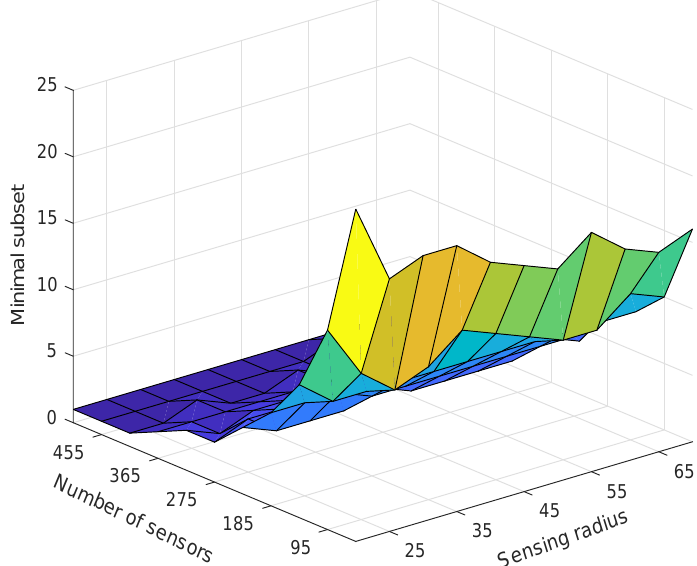
Figure 7. The change trend of the number of nodes in the minimum node set when the number of nodes changes and the node sensing radius